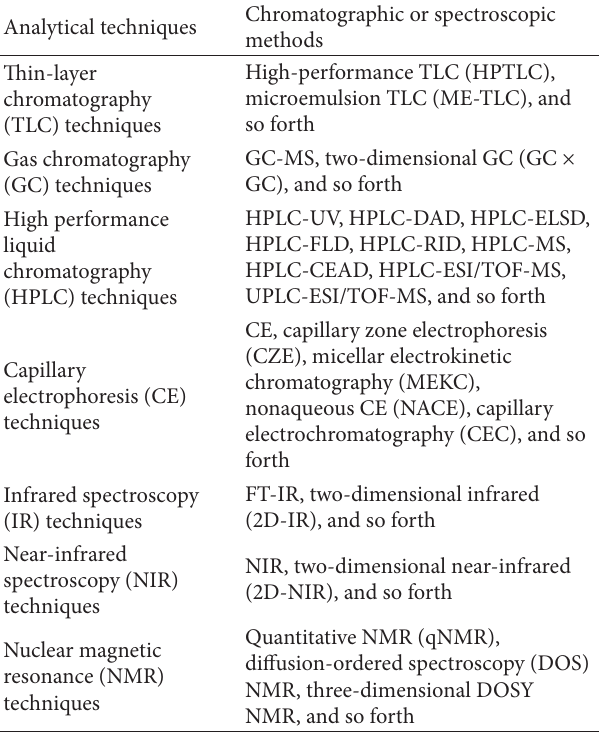
Table 1: The analytical techniques and methods of natural product